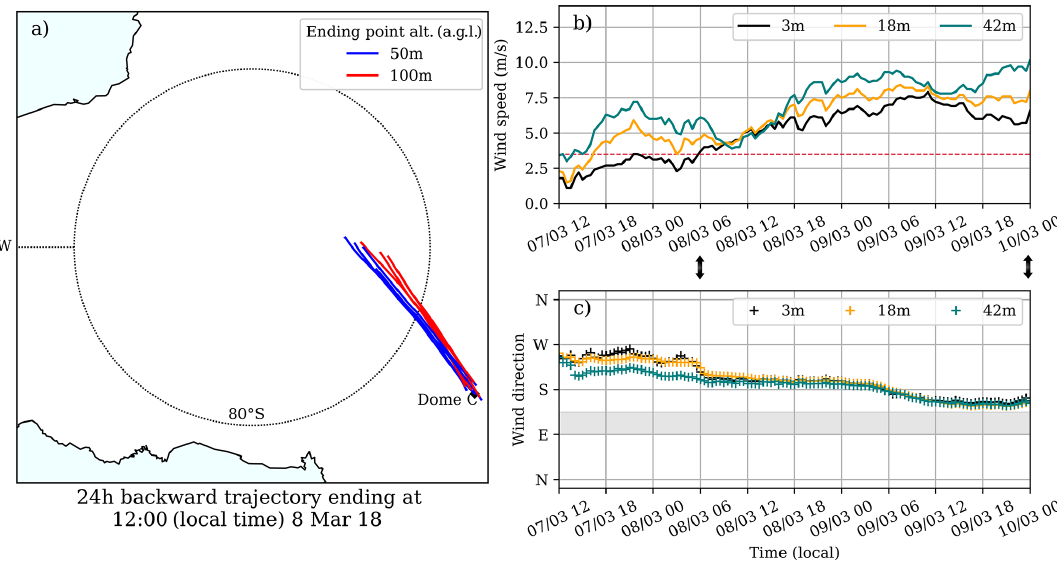
Figure 3. (a) The 2d back trajectories ending at 50 (blue) and 100ma.g.l. (red) at the four grid points closest to Dome C. Panels (b) and (c) show the time series of the wind speed and origin at three levels on the mast. The dashed red line in (b) indicates the 3m wind speed threshold value for snowdrift triggering (see details in the main text). The grey band in (c) delimits the wind direction range in which the flow can possibly be affected by station exhaust. Black arrows indicate the times at which the fog visually appears and disappears near the surface in the lidar